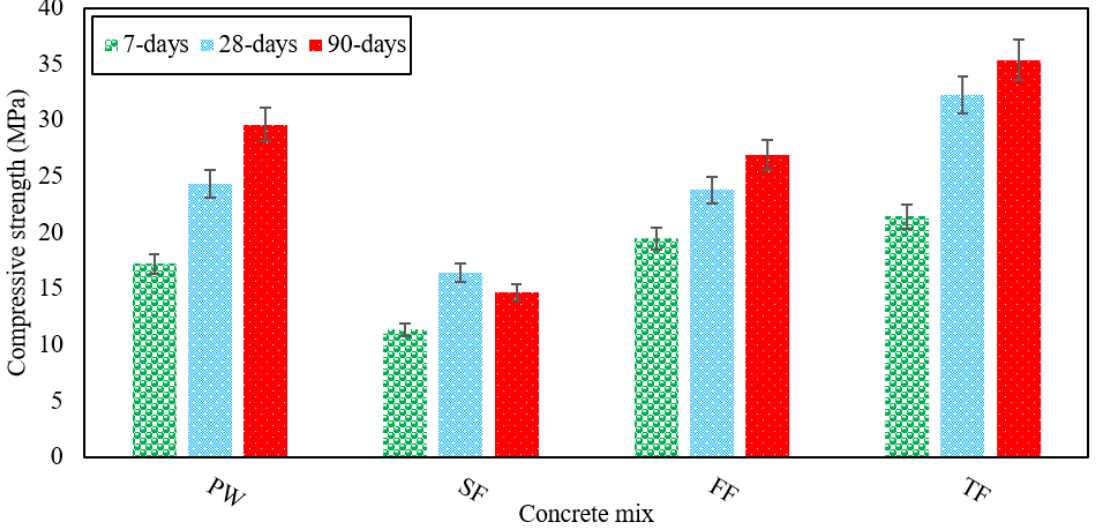
Figure 2. CS of various RAGC mixes at 7, 28, and 90 days of testing.